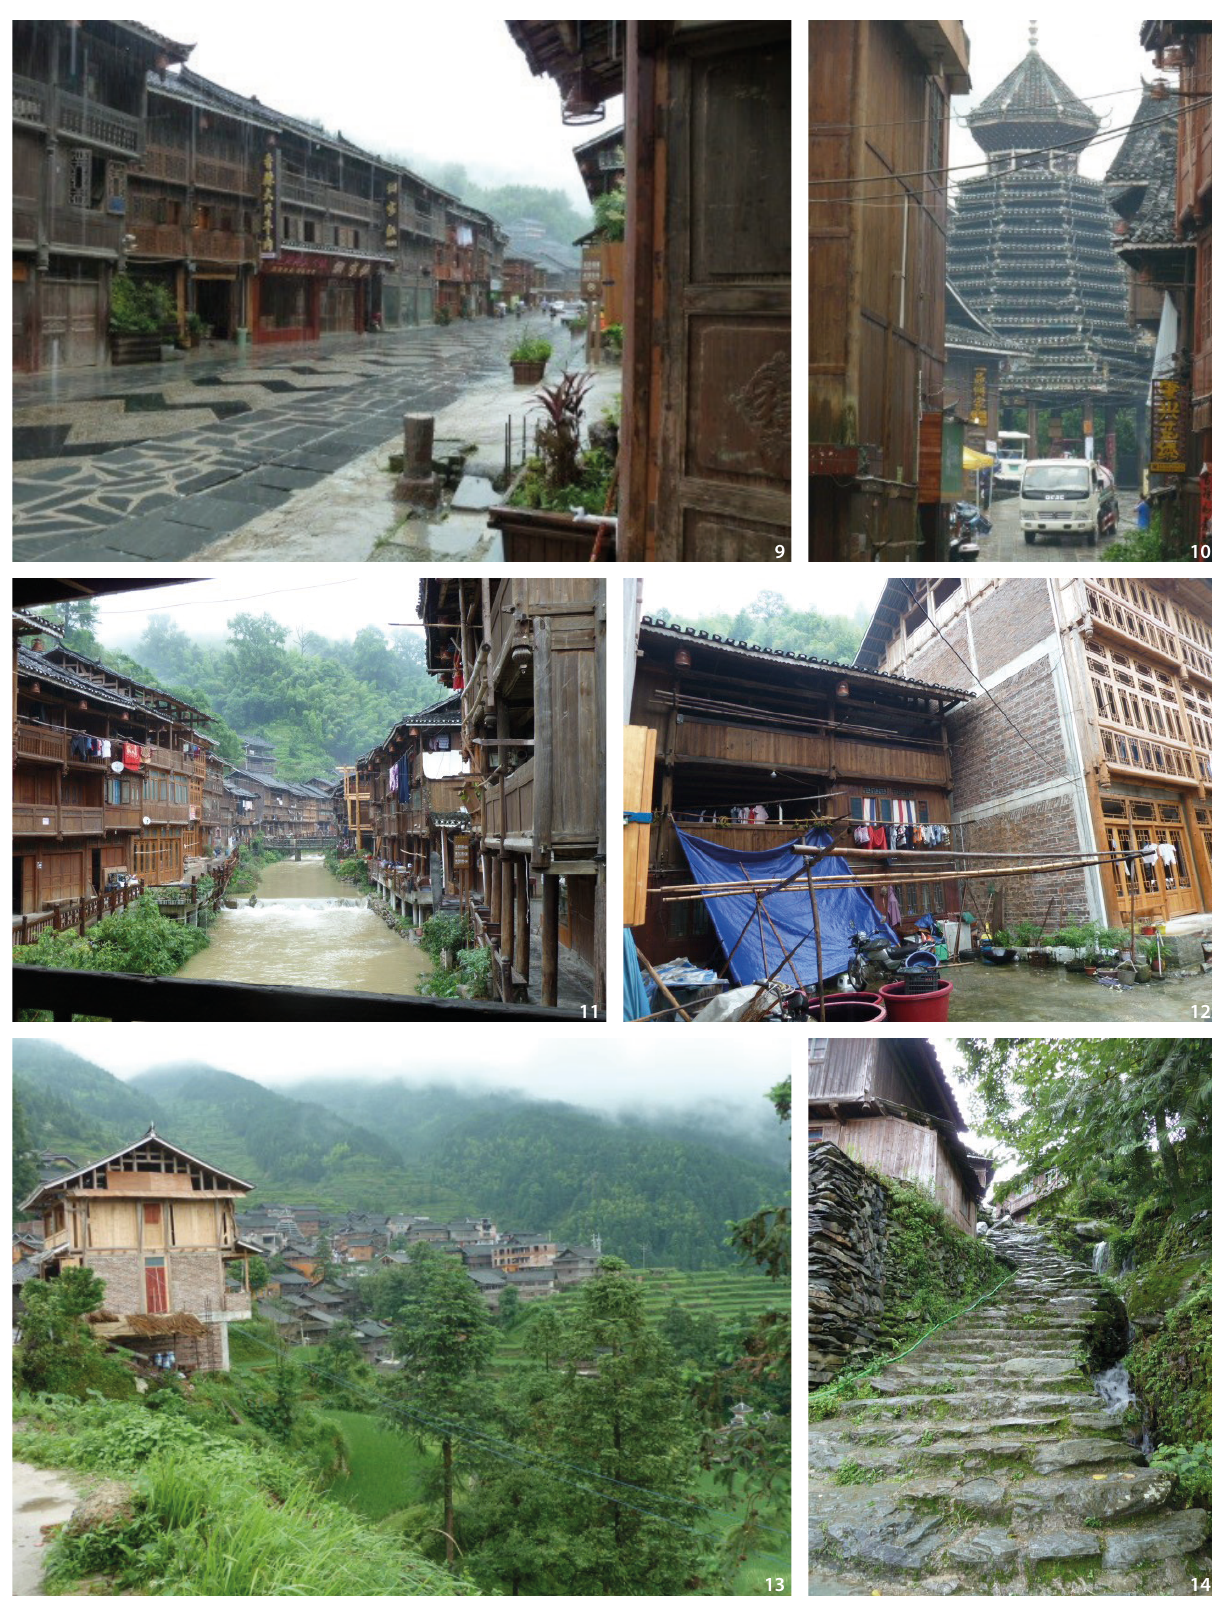
Figure 9 Zhaoxing Dong Village redeveloped main street 2017 (Source: the author). Figure 10 Zhaoxing Dong Village Drum Tower 2017 (Source: the author). Figure 11 Zhaoxing Dong Village old street 2017 (Source: the author). Figure 12 Zhaoxing Dong Village new housing 2017 (Source: the author). Figure 13 Tang'an Dong Village landscape setting 2017 (Source: the author). Figure 14 Tang'an Dong Village character 2017 (Source: the